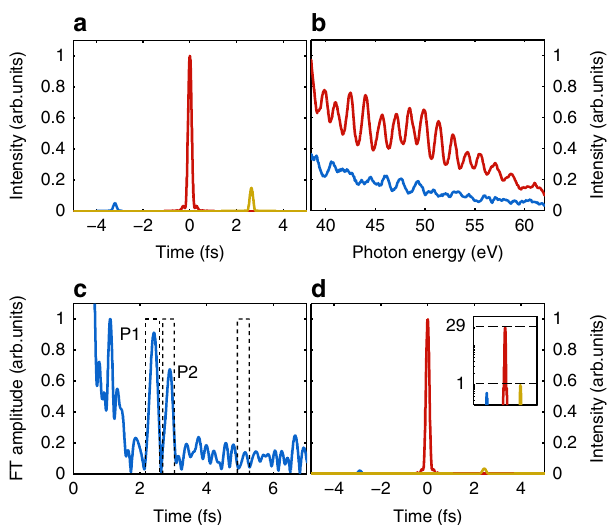
Fig. 6 Highly isolated AP. a Reconstructed temporal structure of the attotrain based on the individual spectra and corresponding phase differences from Fig. 4c, d and assuming a fl at phase for one of the pulses as observed in our simulations. b Measured spectrum (blue) with ϕ CEP ≈ 11 π /6 and L / λ L ≈ 0.5 in comparison with highly modulated spectrum (red) appearing as a result of two equivalently strong APs ( ϕ CEP ≈ π ). c Corresponding FT of the measured XUV spectrum attributed to highly isolated AP. Peaks P1 and P2 represent interference of this dominant AP with weak side ones. P3 is below the noise level due to very low spectral intensity of the side APs. d Reconstructed temporal structure demonstrating minimum isolation degree of the central AP of 30. Inset: AP intensities in logarithmic scale with different normalization for better